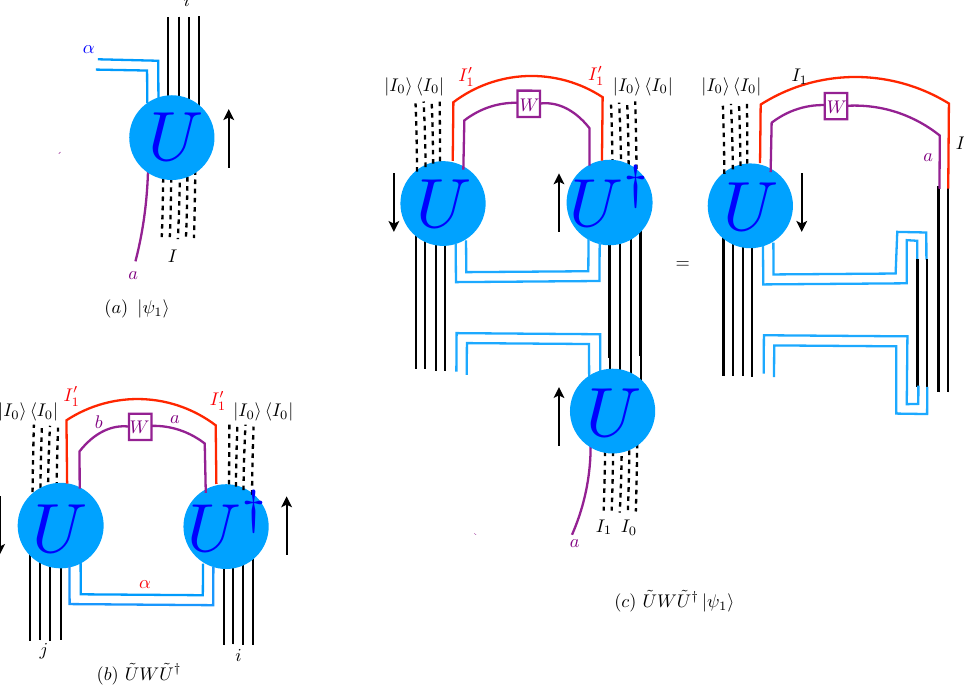
Figure 3 . (a) represents the state | ψ 1 i . (b) represents the operator W A = ˜ UW ˜ U † . (c) repre- sents W A | ψ 1 i